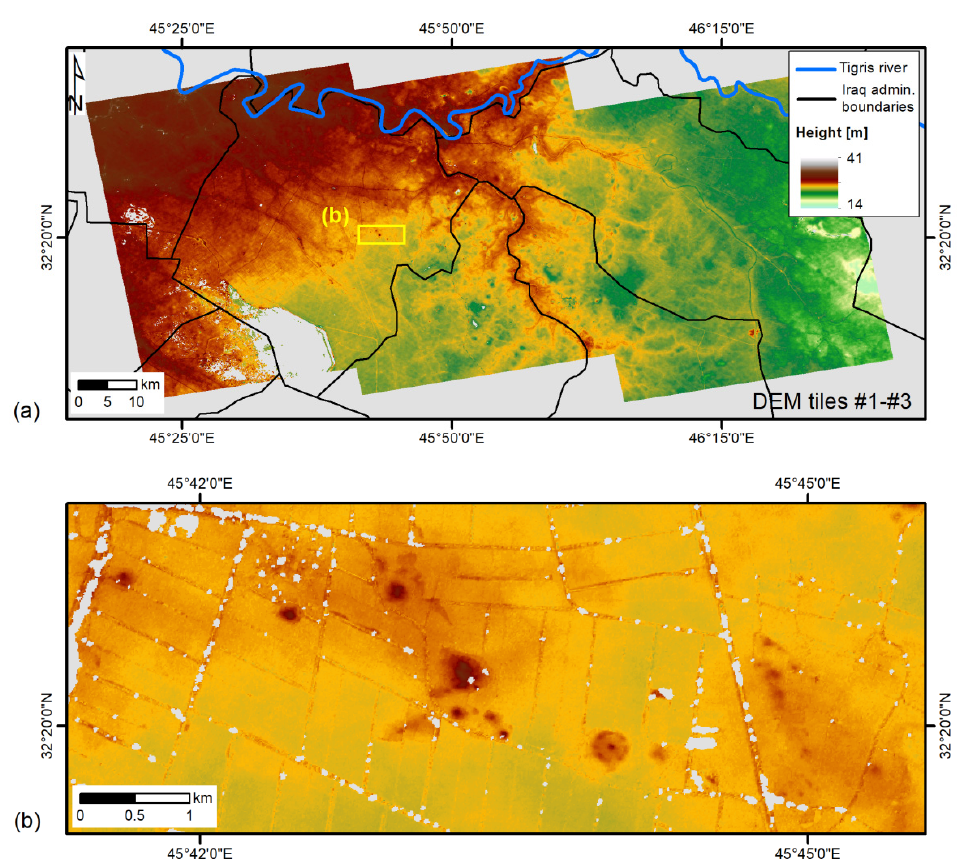
Figure 4. ( a ) Overview of high-resolution COSMO-SkyMed SM DEM tiles #1-#3 with ( b ) zoomed view on a sector with a number of tells and archaeological deposits. COSMO-SkyMed ® Products ©ASI, Italian Space Agency, 2018. All rights reserved.